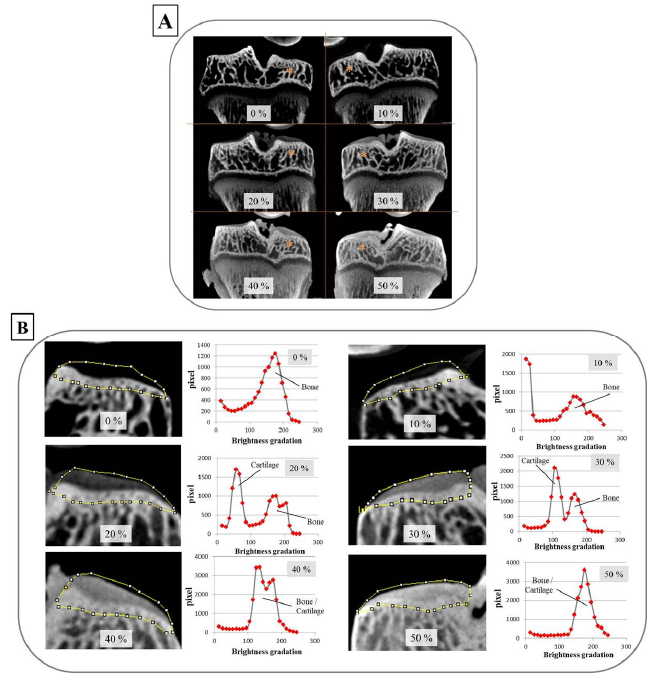
Figure 2. The optimal concentration of Oypalomin for CEX- µ CT was 30%. ( A ) The overall image of tibia frontal sections with the indicated concentrations (%) of Oypalomin. Staining of the articular cartilage of the tibial plateau was dependent on the Oypalomin concentrations. The asterisks indicate the medial tibial condyle. ( B ) Brightness measurements reflected X-ray absorptions of the articular cartilage and subchondral bone. The regions of interest (ROIs) surrounded by the yellow line were determined manually. Brightness and pixels within the ROI are plotted as histograms. The optimal concentration of Oypalomin to differentiate cartilage and bone was 30%.